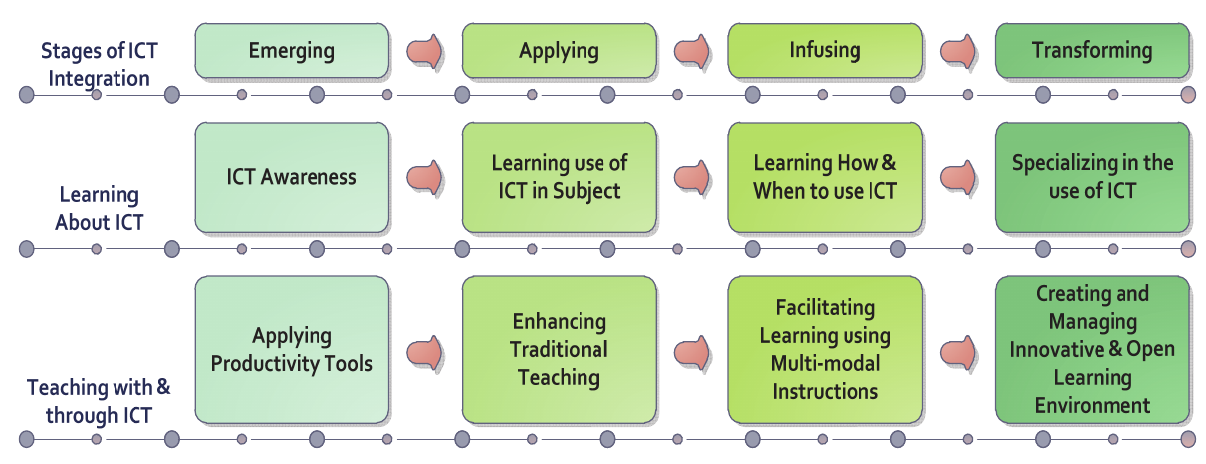
Figure 3: Mapping between various stages of ICT integration with